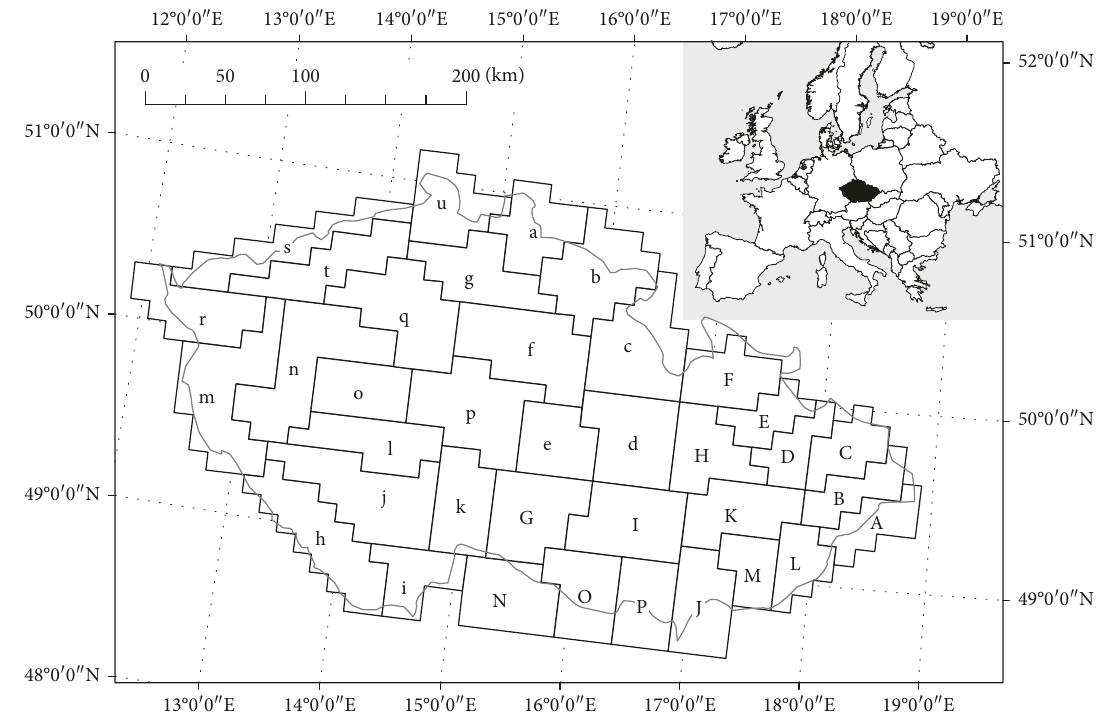
Figure 1: Study area. Hydrological regions for rainfall prediction